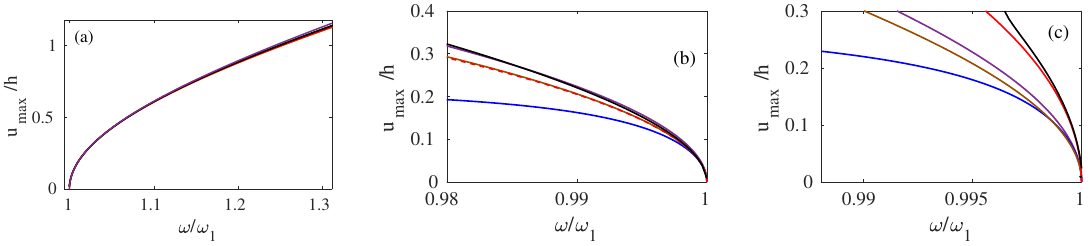
Figure 5. The backbone curves for ( a ) the straight beam, ( b ) the shallow arch, and ( c ) the non-shallow arch. The reference solution with numerical continuation is in black. Comparison of the reduction methods with a single master coordinate; purple: ICE method, blue: QM–SMD, brown: QM–MD, and red: